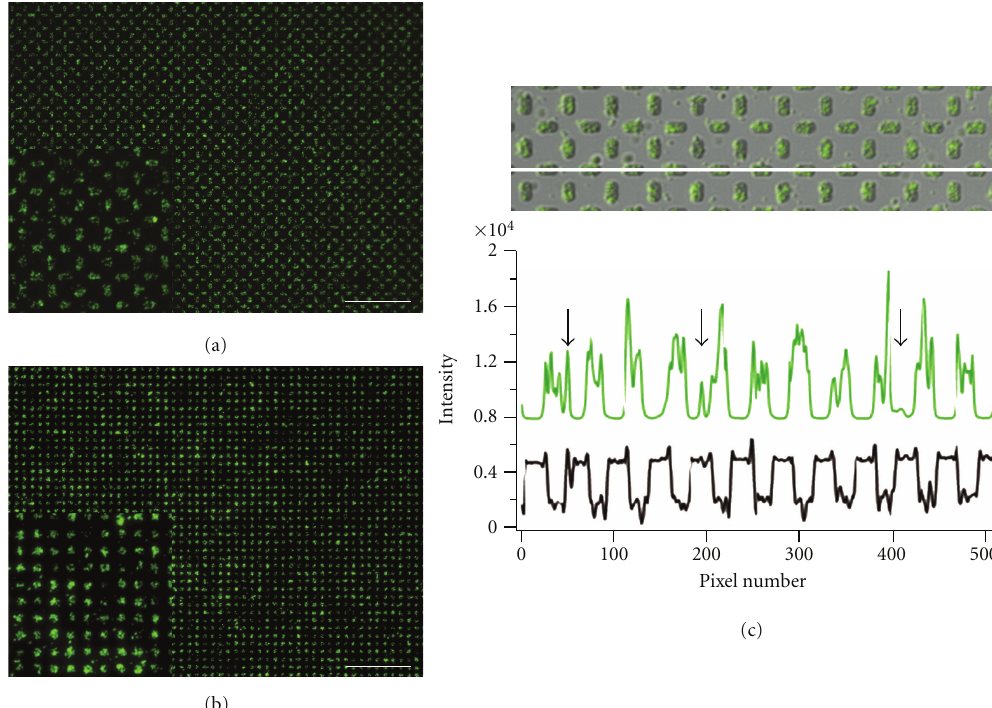
Figure 4: Three-strand DNA assembly on a mimic array (patterned on a GaAs substrate) for (a) complementary target only and (c) 10 ppm target in nontarget DNA. The inlays in the lower left of (a) and (c) are an enlarged portion of (a) and (c), respectively. Scale bars = 50 µ m. (b) A line scan of the wide-field fluorescence microscopy image in (a) showing fluorescein-labeled probe DNA (green) and DIC (black) intensity correlates fluorescence intensity with nanobeads located primarily over gold pads, where the black arrows signify the presence of a small number of nonspecifically bound